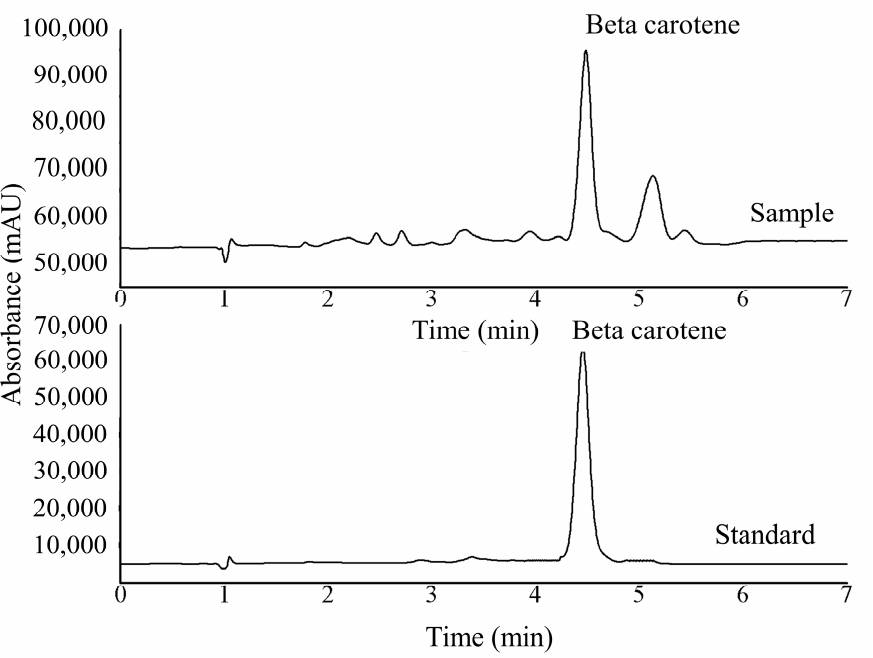
Figure 2. Chromatogram of a C. maxima sample solution and β -carotene standard (10 mg/L). Linearity was evaluated for the concentrations of 0.5, 1, 2, 5, 10, 20, 50, and 100 mg/L, and linear regression was obtained by plotting the area of the β -carotene peak as a function of the concentration of each standard. The detector response at 450 nm was linear through- out the calibration interval. Good linearity was achieved by the high correlation coefficient value (R 2 =